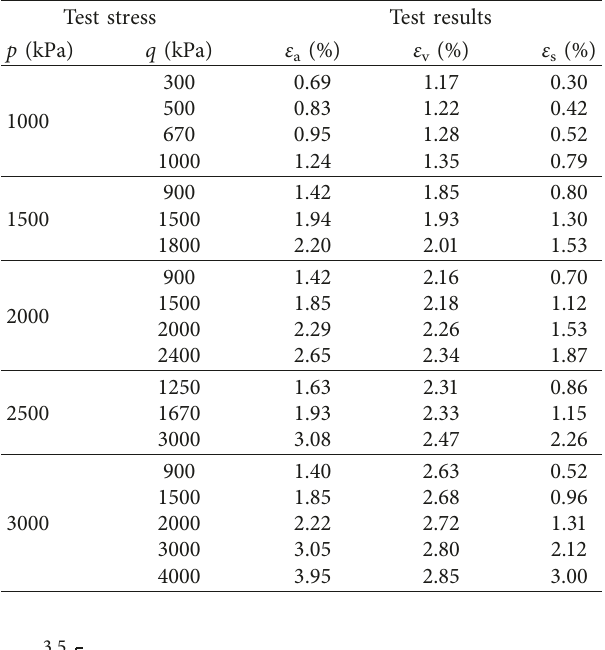
Table 2: Test stress conditions and test results (stress conditions of equal p and unequal q ).